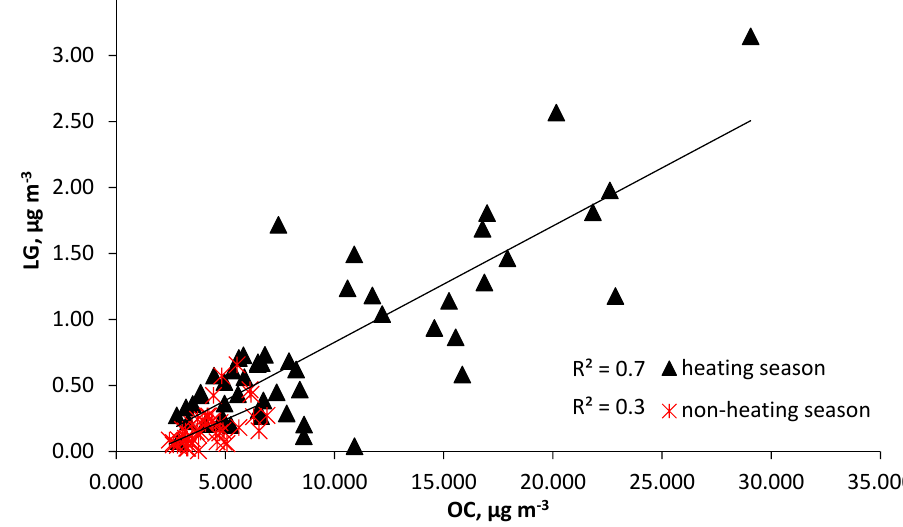
Figure 9. Relationship LG vs. OC for the heating and non-heating seasons.